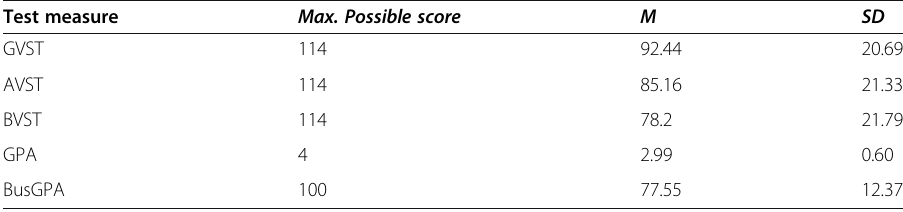
Table 1 Summary of scores on testing measures ( n = 94) Test measure